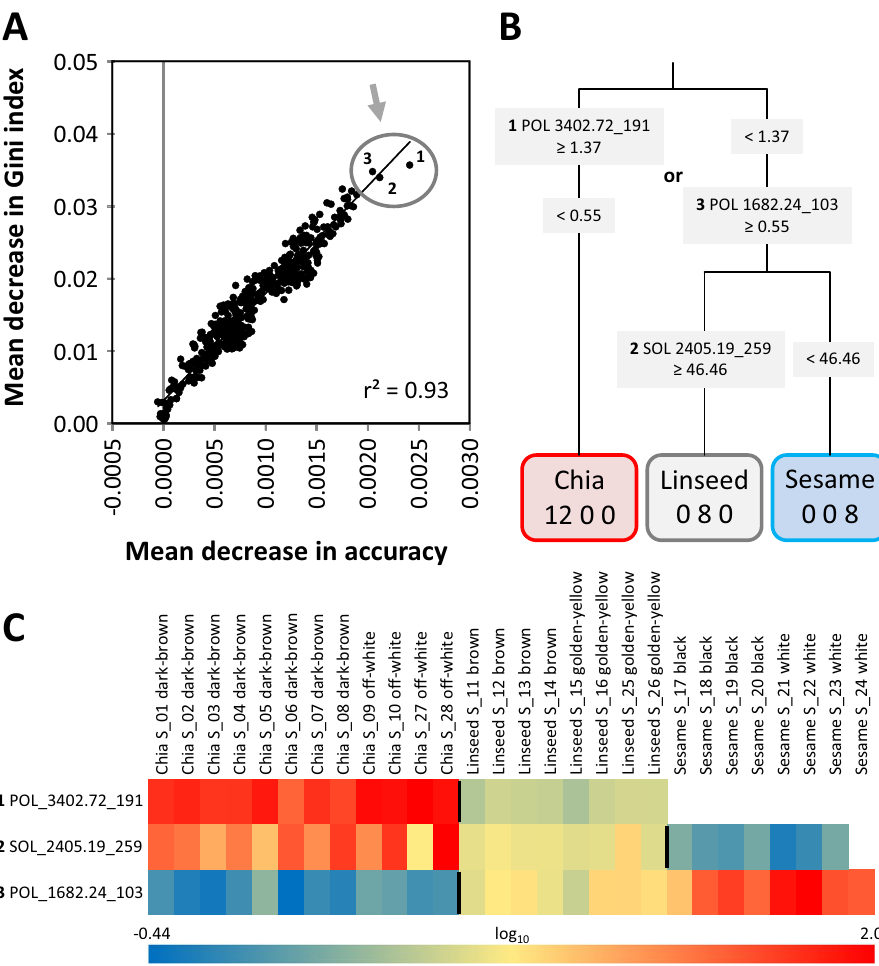
Figure 3. RF based analysis of seed identity markers from mass features of non-targeted metabolite profiles of three chemical fractions from chia, linseed and sesame seeds. Analysis of variable importance using the mean decrease of Gini index and mean decrease of accuracy measures of random forest (RF) analyses. The three most important variables, i.e. mass features, are indicated by circle and arrow. Ten random forest analyses were performed by repeated random selection of 14 training profiles from 28 seed batches. The mean decrease in Gini index and mean decrease in accuracy measures of mass features were averaged across the random forest analyses. None of the classification models had errors. Linear correlation, r² of a Pearson’s correlation coefficient, of the averaged variable importance measures is inserted. Averaged normalized abundances of the mass features across technical replicates of the VOC, POL and SOL analyses were used (Table S2). Mass features were pre-selected according to 1-way ANOVA (P < 10 − 5 ) significance for the distinction of seed types. Redundancy of mass features was reduced by selecting the most significant feature with least missing values among multiple mass features of the same compound. ( A ) Decision tree representation of two rule sets that distinguish seed material without false classifications. The rules were based on the three most important mass features. Mass features are reported by analysed fraction, chromatographic retention time RT (VOC) or retention index RI (POL, SOL) and nominal mass. The numerical values in the tree are the thresholds of normalized abundances for partitioning of the seed samples. ( B ) Heat map representation of the normalized abundances of the three most important mass features. The normalized abundances were maximum scaled and log 10 -transformed for visualization, maximum (red), mean (yellow), minimum (blue), and non-detected (white). Vertical bars within the heat map indicate the partitioning depicted in panel